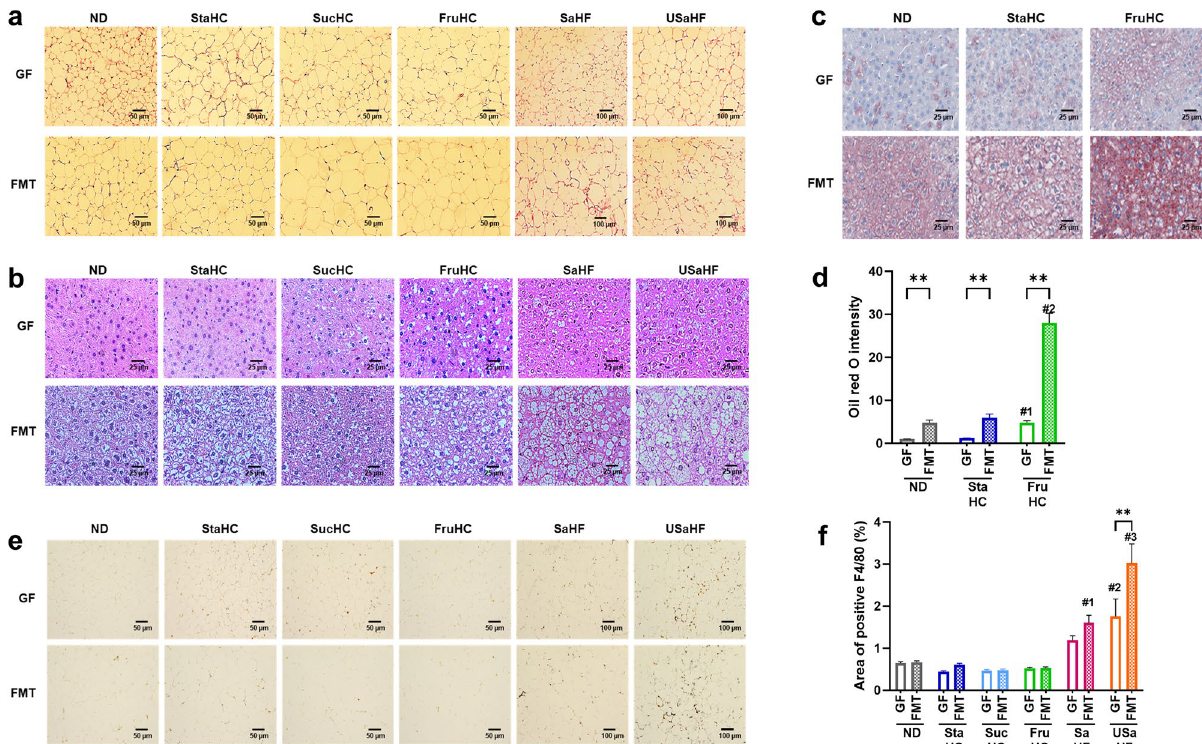
Figure 3. Histological analysis of iWAT and liver in germ-free (GF) and fecal microbiota transplant (FMT) mice fed six different diets. ( a ) Representative images of iWAT stained with hematoxylin and eosin (HE). Scale bar: 50 μm for ND, StaHC, SucHC, and FruHC; 100 μm for SaHF and USaHF. ( b ) Representative images of the liver stained with HE. Scale bar, 20 μm. ( c ) Representative images of the liver stained with Oil Red O. Scale bar, 20 μm. ( d ) Quantification of Oil Red O positive area. Values are presented as the mean + SEM (n = 4 per group); the GF-ND group was calculated as one. Multiple comparisons were analyzed using a two-way analysis of variance, followed by Tukey’s test. Asterisks (*) indicate significant differences between GF and FMT mice (** p < 0.01), and the # denotes the following significances between the diet groups: #1 FruHC vs ND ( p = 0.037) and StaHC ( p = 0.044); #2 FruHC vs ND and StaHC ( p < 0.0001). ( e ) Immunohistochemistry for F4/80 staining of iWAT. Scale bar, 50 μm for ND, StaHC, SucHC, and FruHC; 100 μm for SaHF and USaHF. Magnification, × 200. ( f ) Quantification of the F4/80 positive area. Values are presented as the mean + SEM (n = 4 per group). Multiple comparisons were analyzed using a two-way analysis of variance, followed by Tukey’s test. Asterisks (*) indicate significant differences between GF and FMT (** p < 0.01), and the # denotes the following significances between the diet groups: #1 SaHF vs ND ( p = 0.043), StaHC ( p = 0.026), SucHC ( p = 0.007), and FruHC ( p = 0.012); #2 USaHF vs ND ( p = 0.008), StaHC ( p = 0.001), SucHC ( p = 0.001), and FruHC ( p = 0.002); #3 USaHF vs ND, StaHC, SucHC, and FruHC ( p < 0.0001), vs SaHF ( p = 0.0003). iWAT inguinal white adipose tissue, ND normal diet, StaHC high-starch diet, SucHC high-sucrose diet, FruHC high-fructose diet, SaHF saturated fatty acid-rich high-fat diet, USaHF unsaturated fatty acid-rich high-fat